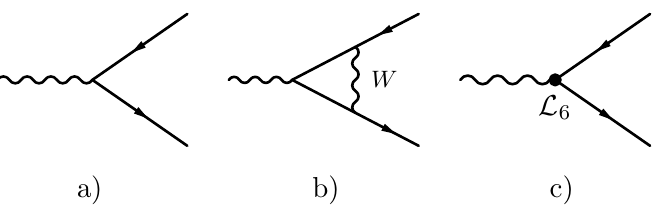
Figure 4 . Interference diagrams for anomalous three point interactions in the